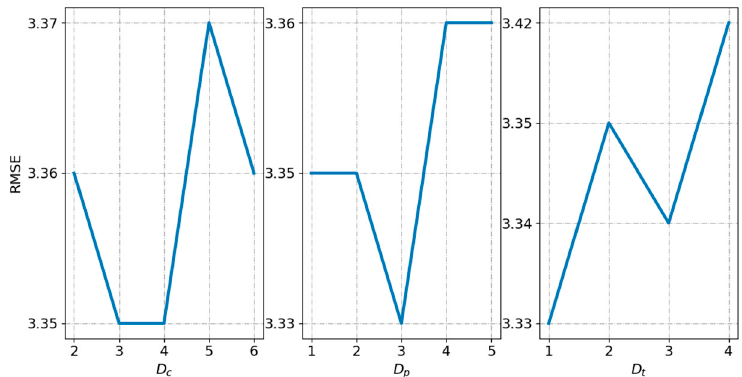
Figure 5. Tuning the length of closeness, period and Figure 5 . Tuning the length of closeness, period and trend.